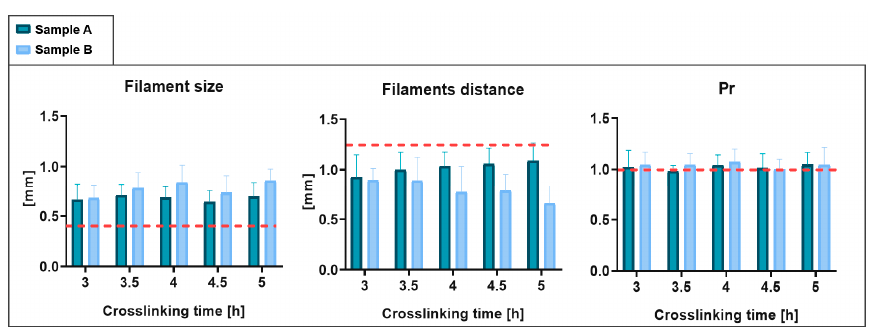
Figure 3. Quantitative printing-performance results: operator and protocol repeatability. The results obtained with Sample A and with Sample B are compared. The dashed red line indicates target values.